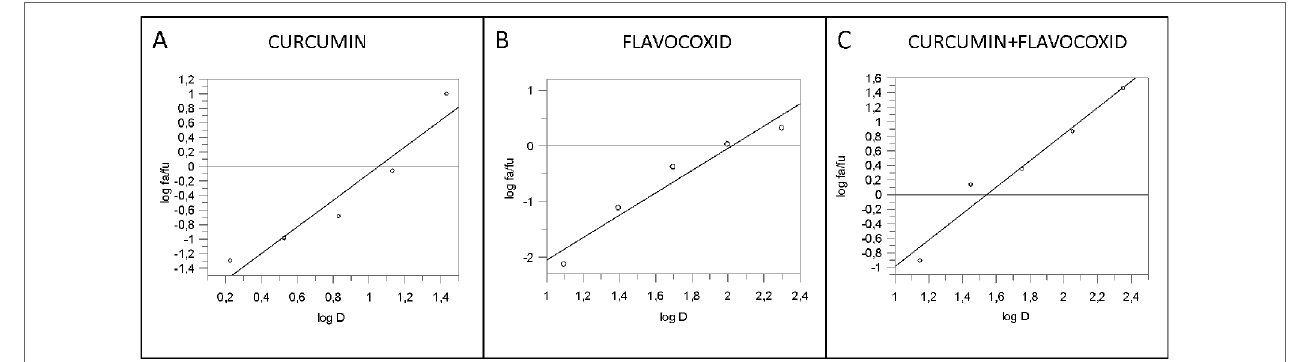
FIgURE 2 | Median effect plot for curcumin (panel A ), flavocoxid (panel B ), and curcumin -flavocoxid in combination (molar ratio, 1:7.3) (panel C ). D is the dose, f a and f u the affected and the unaffected fraction, respectively by the dose